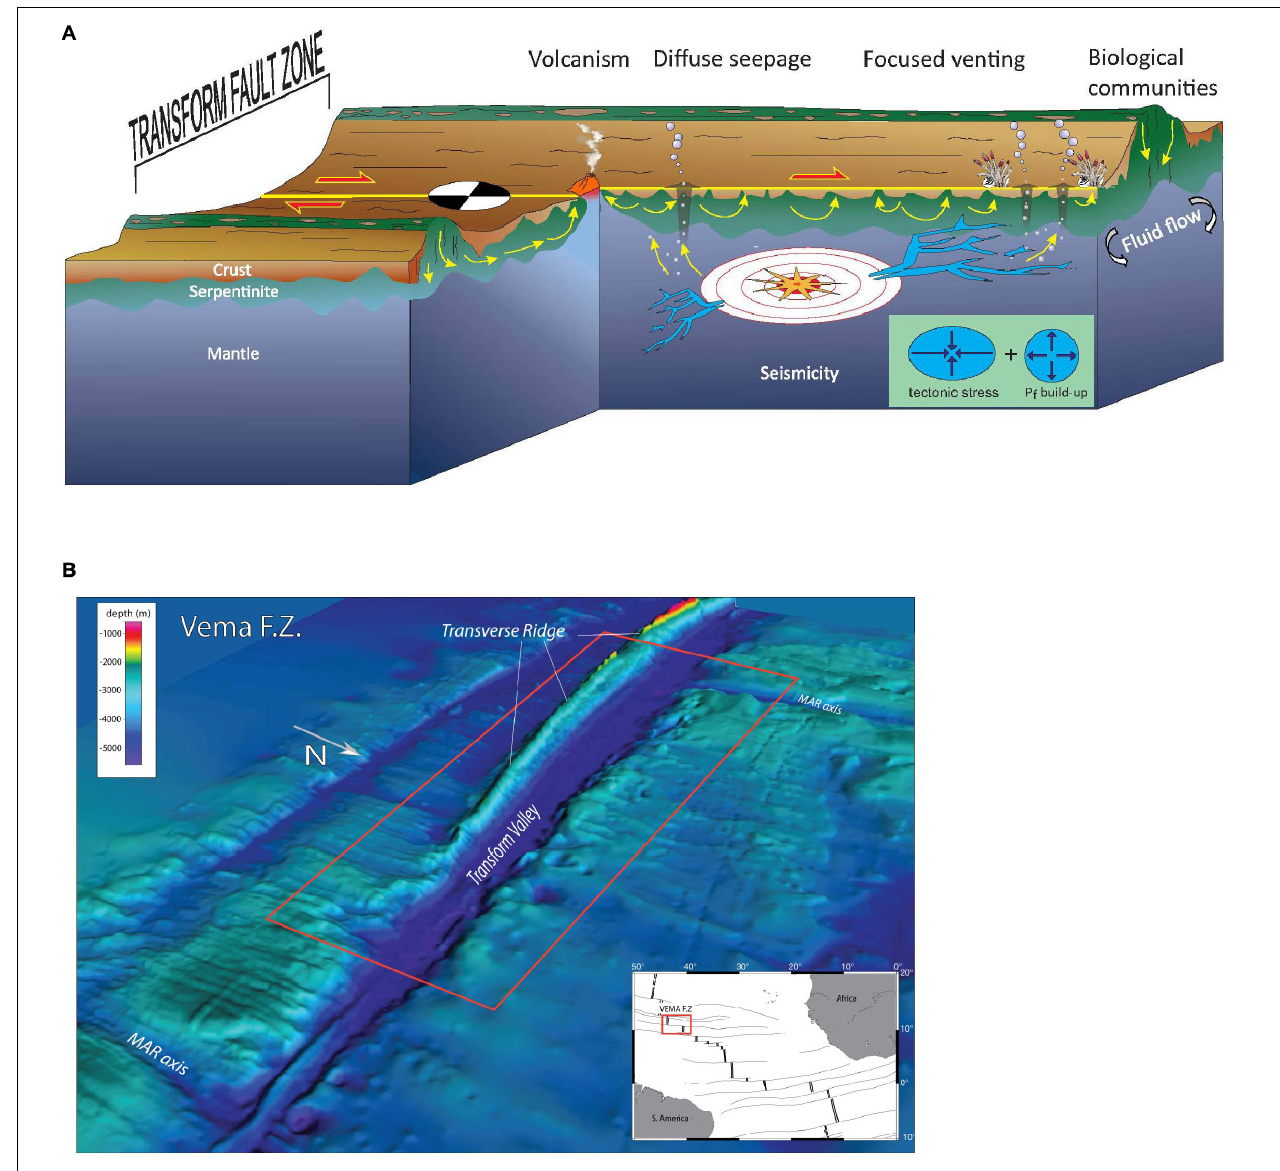
FIGURE 3 | (A) Sketch illustrating the interaction of seismicity, fluid-flow, geochemical reactions, and life at and below the seafloor at MTFFZs inspired by (B) a 3D model of the Vema transform fault in the Equatorial Atlantic (based on multibeam bathymetric data collected during the PRIMAR-S19 Cruise; Fabretti et al., 1998; Bonatti et al., 2003). The large red rectangle indicates a typical location for the area sketched in the upper panel.